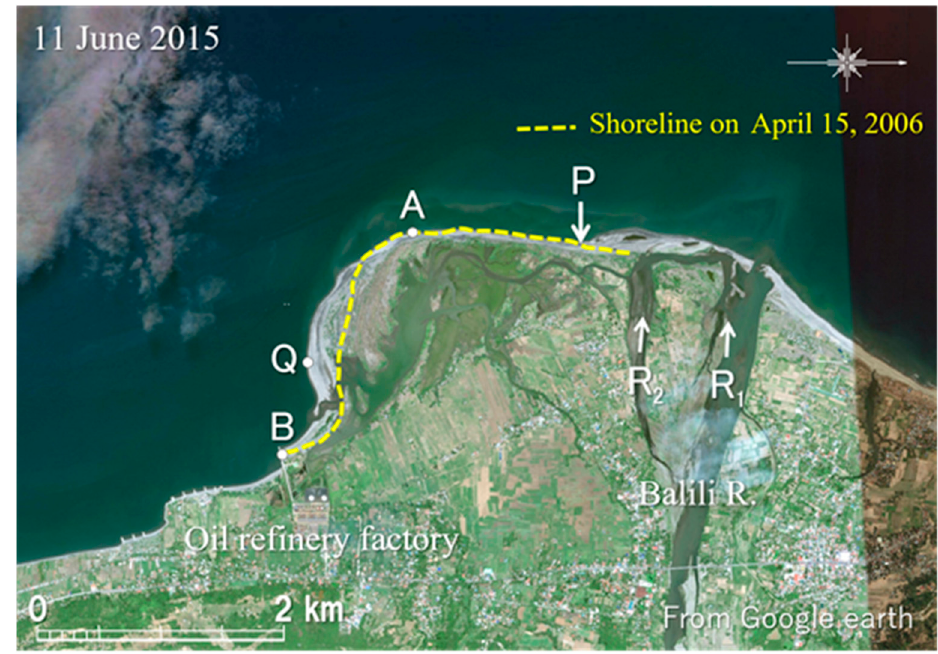
Figure 5. Satellite image of shoreline around Balili River mouth (11 June 2015). This sandbar further approached B until 20 February 2016 (Figure 6).